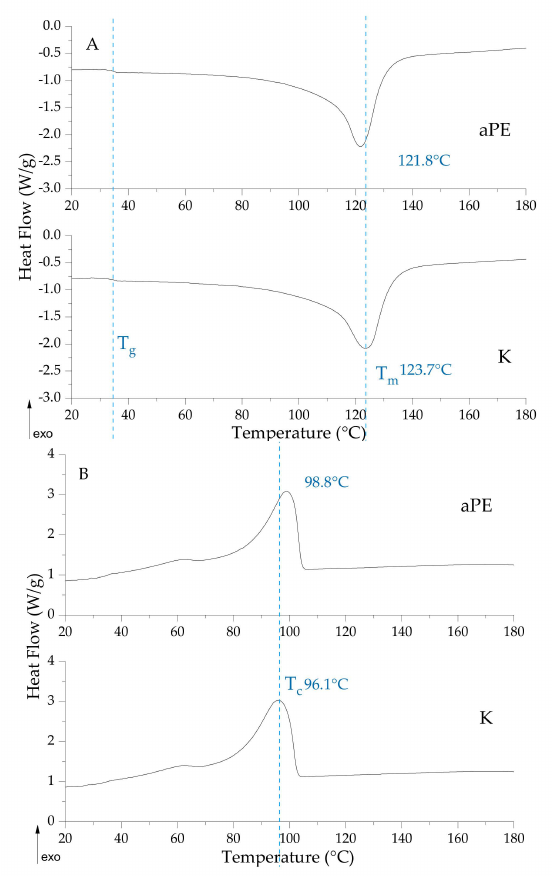
Figure 10. DSC curves of the films in heating ( A ) and cooling ( B ) scan; T g —glass transition, T m — melting transition, T c —crystallization